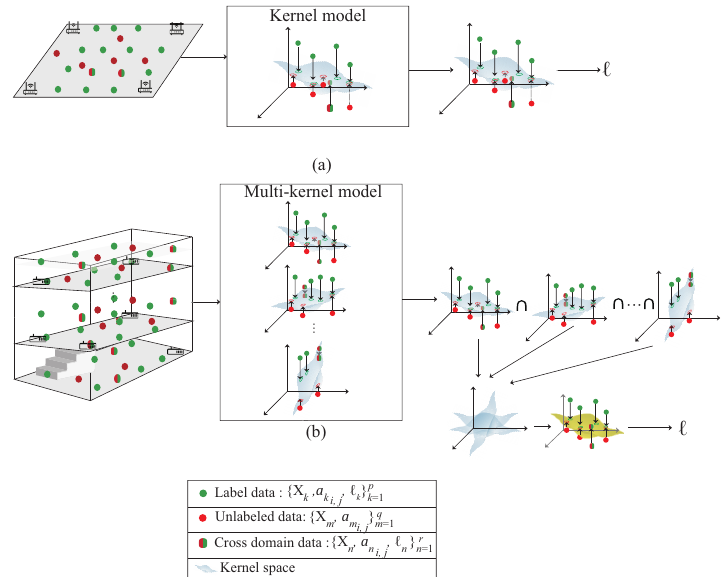
Figure 3. A comparison with ( a ) single kernel learning based on SVM and ( b ) the multi-kernel based semi-supervised learning.